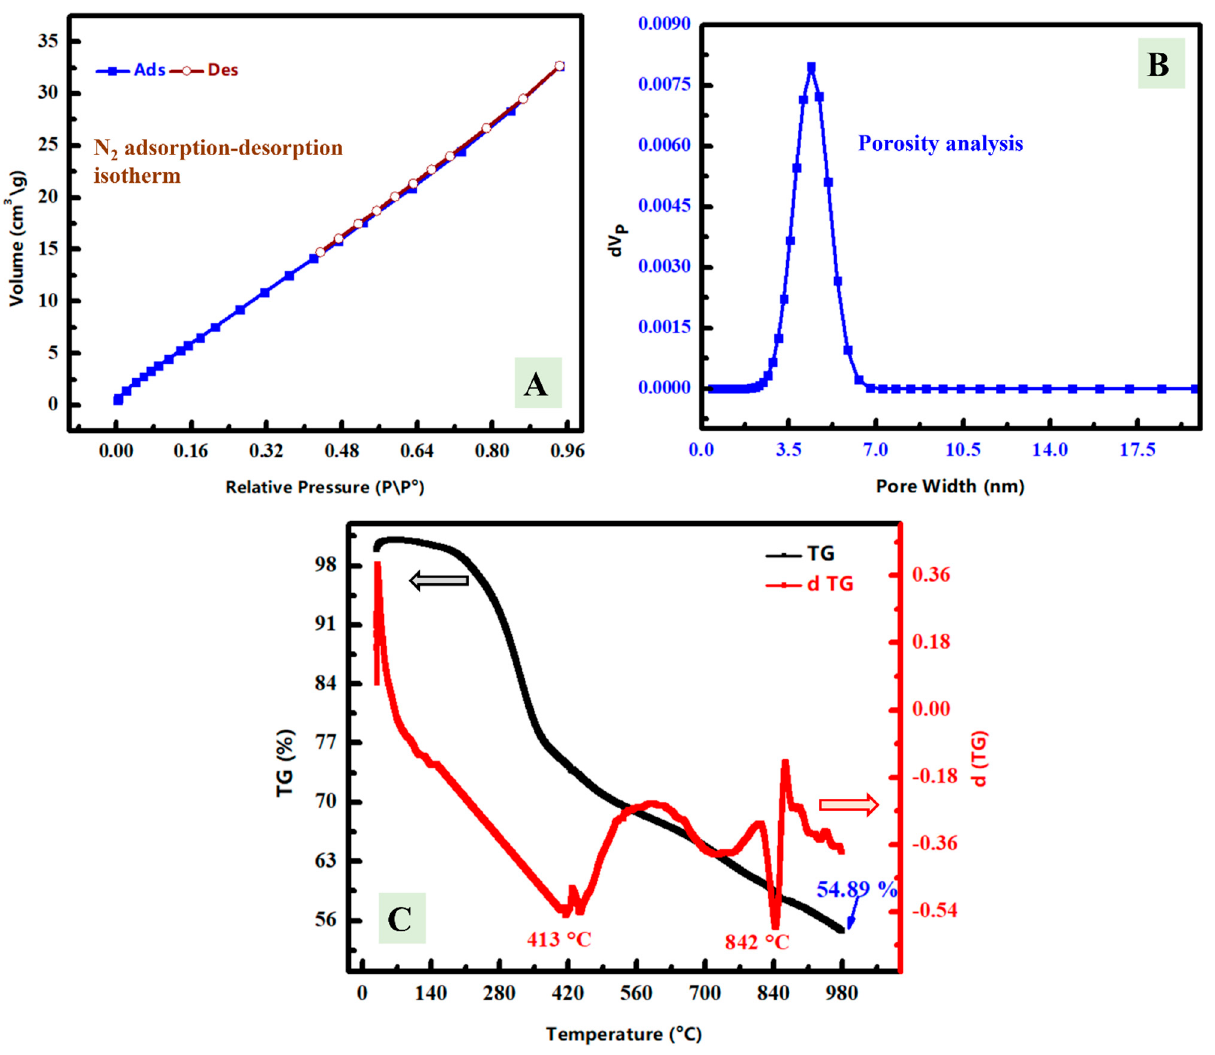
Figure 4. ( A ) Nitrogen adsorption-desorption analysis of the synthesized ZnNiO@PANE composite. ( B ) Pore width analysis of the synthesized ZnNiO@PANE composite. ( C ) TGA and DTG analyses of the synthesized ZnNiO@PANE composite.